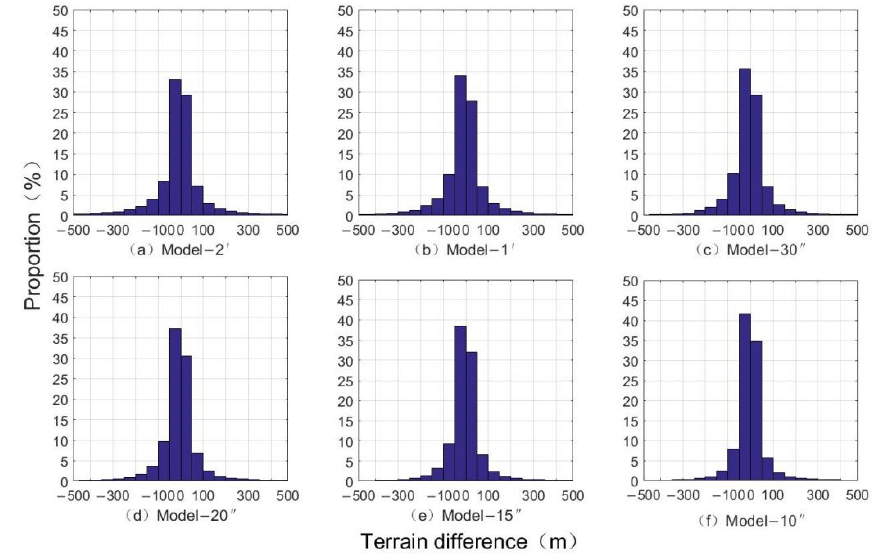
Figure 7. The proportion distribution of inversed seafloor topography difference ratios.